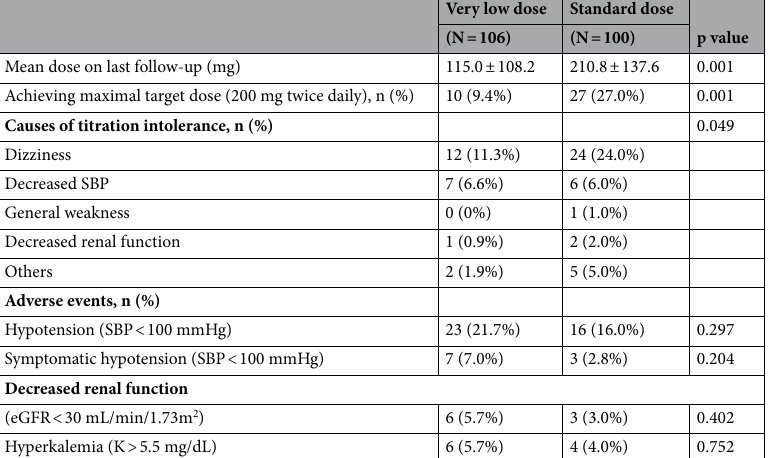
Very low dose Standard dose